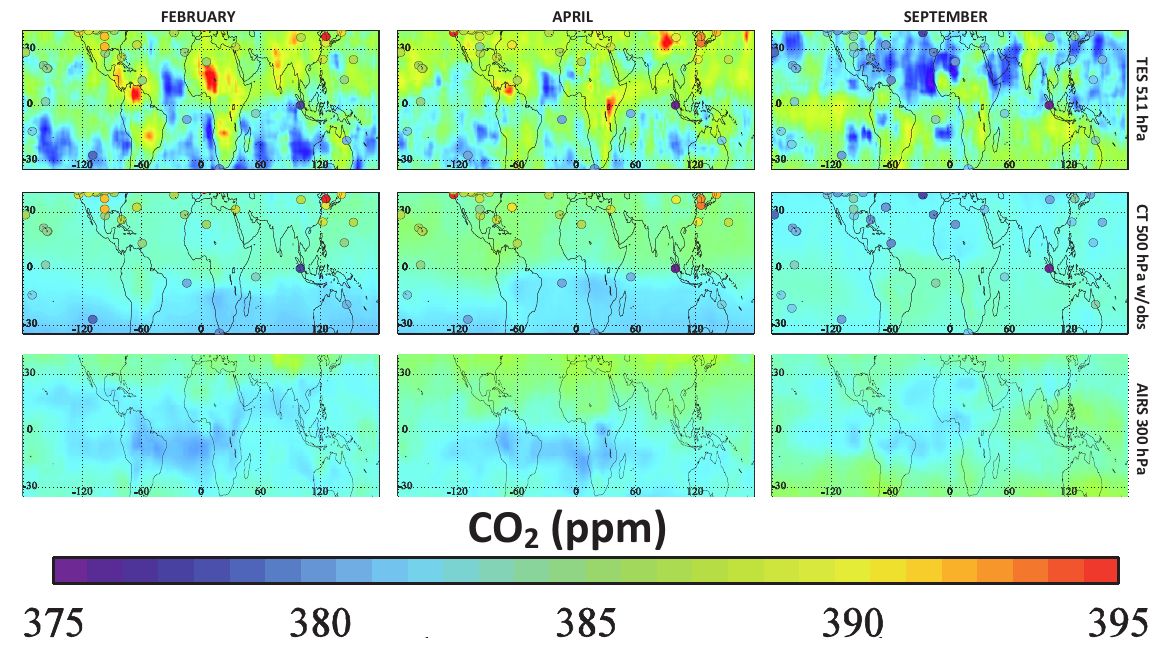
Fig. 14. TES (top), CarbonTracker at 500 hPa with the TES observation operator (middle), and AIRS (bottom) for February, April, and September, 2007. The small circles show values for 15 ◦ × 15 ◦ monthly averages of TES and CarbonTracker sampled at the TES observation locations with the background color showing interpolation between these points. The AIRS data are shown as 2 ◦ × 2.5 ◦ monthly averages. The large circles show GLOBALVIEW surface values. Some enhancements over land seen in TES are also seen in CarbonTracker data near the surface. In general TES exhibits more variability than CarbonTracker at 500hPa. AIRS, TES, and CarbonTracker all show high values in the Northern Hemisphere in April, as expected, and the reverse in September. All color scales are the